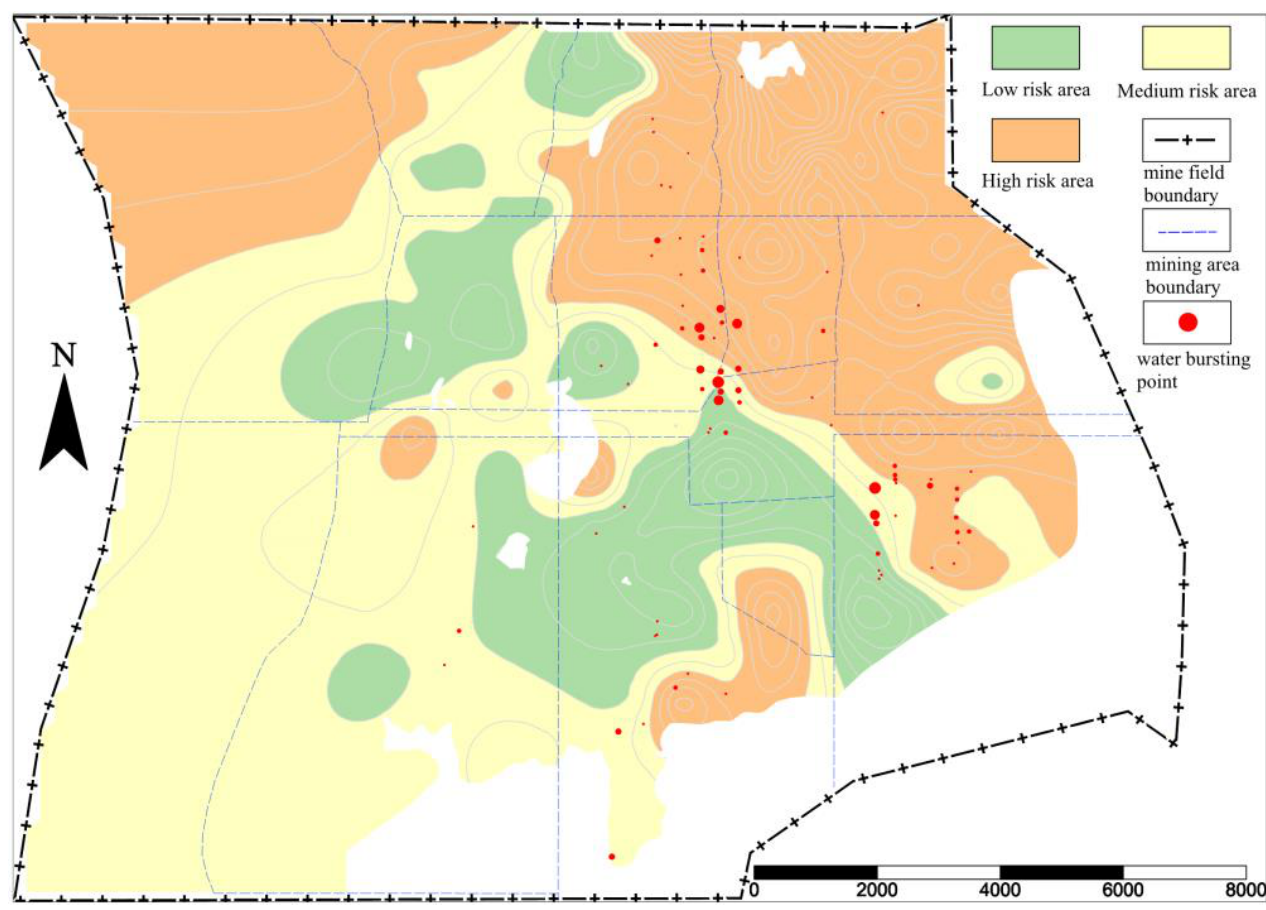
Figure 8. Dangerous zoning of water inrush from the roof of the lower No. 3 coal seam.